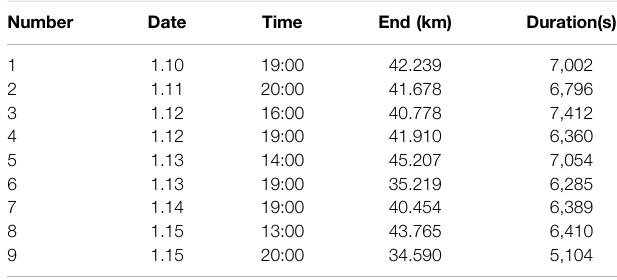
TABLE 1 | Basic information of nine deployed sondes, including release Time (Date, Time), End height (End), Duration (Duration).